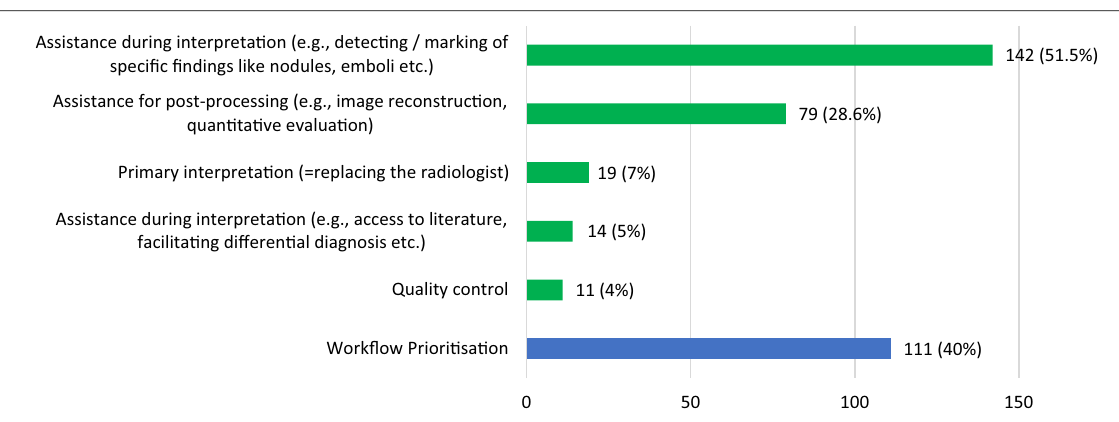
Fig. 1 Which type of scenario (use case) was addressed by the used AI algorithm(s) in clinical routine? The answers of all 276 respondents with practical clinical AI experience are shown, including the number of respondents using one or more algorithms for assistance in diagnostic interpretation (green) and/ or workflow prioritisation (blue)